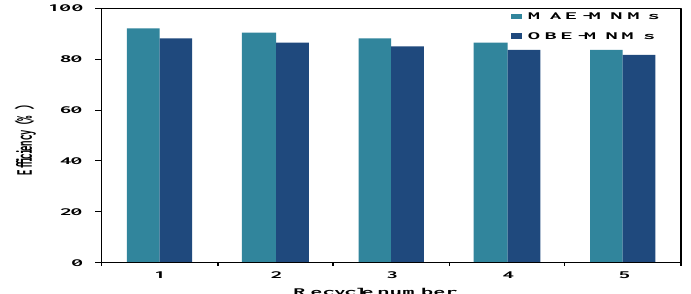
Figure 9. Efficiency on the collection of oil spills of recycled magnetite nanomaterials coated by M. aurea extract (MAE-MNMs) (light blue bars) and O. baccatus extract (OBE-MNMs) (dark blue bars).